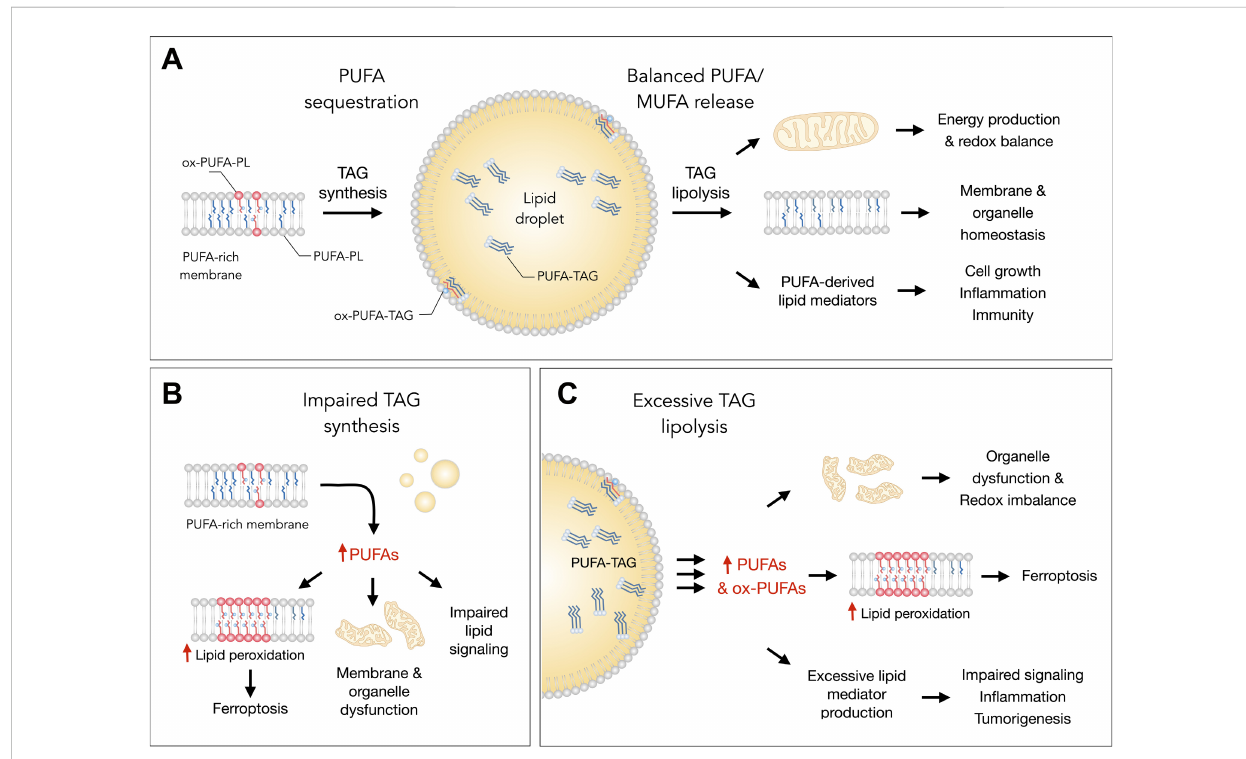
FIGURE 1 Lipid droplets (LDs) control essential cellular processes and protect from ferroptosis by balancing polyunsaturated fatty acid (PUFA) sequestration and release. (A) Under homeostatic conditions, the biosynthesis of triacylglycerols (TAGs) enriched with PUFAs (PUFA-TAGs) and their packaging in LDs may lower the abundance of oxidizable PUFAs esteri fi ed in membrane phospholipids (PUFA-PLs). In principle, already oxidized PUFAs esteri fi ed in phospholipids (oxPUFA-PLs) could also be transferred into LDs and stored as oxidized TAGs (ox-PUFA-TAGs). On the other hand, the balanced release of monounsaturated fatty acids (MUFAs) and PUFAs via TAG lipolysis maintains proper membrane composition, thereby preventing lipid peroxidationandreducingferroptosissensitivity.PUFAreleasefromLDsalsosupportsenergyproduction,mitochondrialfunctionandtheredoxbalance. In addition, lipolysis also delivers PUFAs into oxygenation pathways that convert these FAs into signaling mediators, such as prostaglandins and leukotrienes, which regulate various cellular functions, including cell growth, in fl ammation and immunity. (B) Under various stress conditions, impaired TAG synthesis may lead to an enrichment of membranes with PUFAs that can result in elevatedlipid peroxidation and ferroptosis. Excess PUFAs may also overload mitochondria and other organelles, as well as disrupt the biosynthesis of lipid mediators. (C) Excessive breakdown of LDs by neutral lipases (at the lipid droplet surface) or acid lipases (in the lysosome) during acute or chronic stress may disrupt organelle function, impair redox signaling and metabolism,andenrichmembraneswithPUFAs.Thiscanincreaselipidperoxidationlevelsandsensitivitytoferroptosis.ThereleaseofexcessPUFAsfrom LDs may also stimulate the production of proin fl ammatory and pro-tumorigenic lipid mediators, which can overstimulate mitogenic, in fl ammatory and other signaling